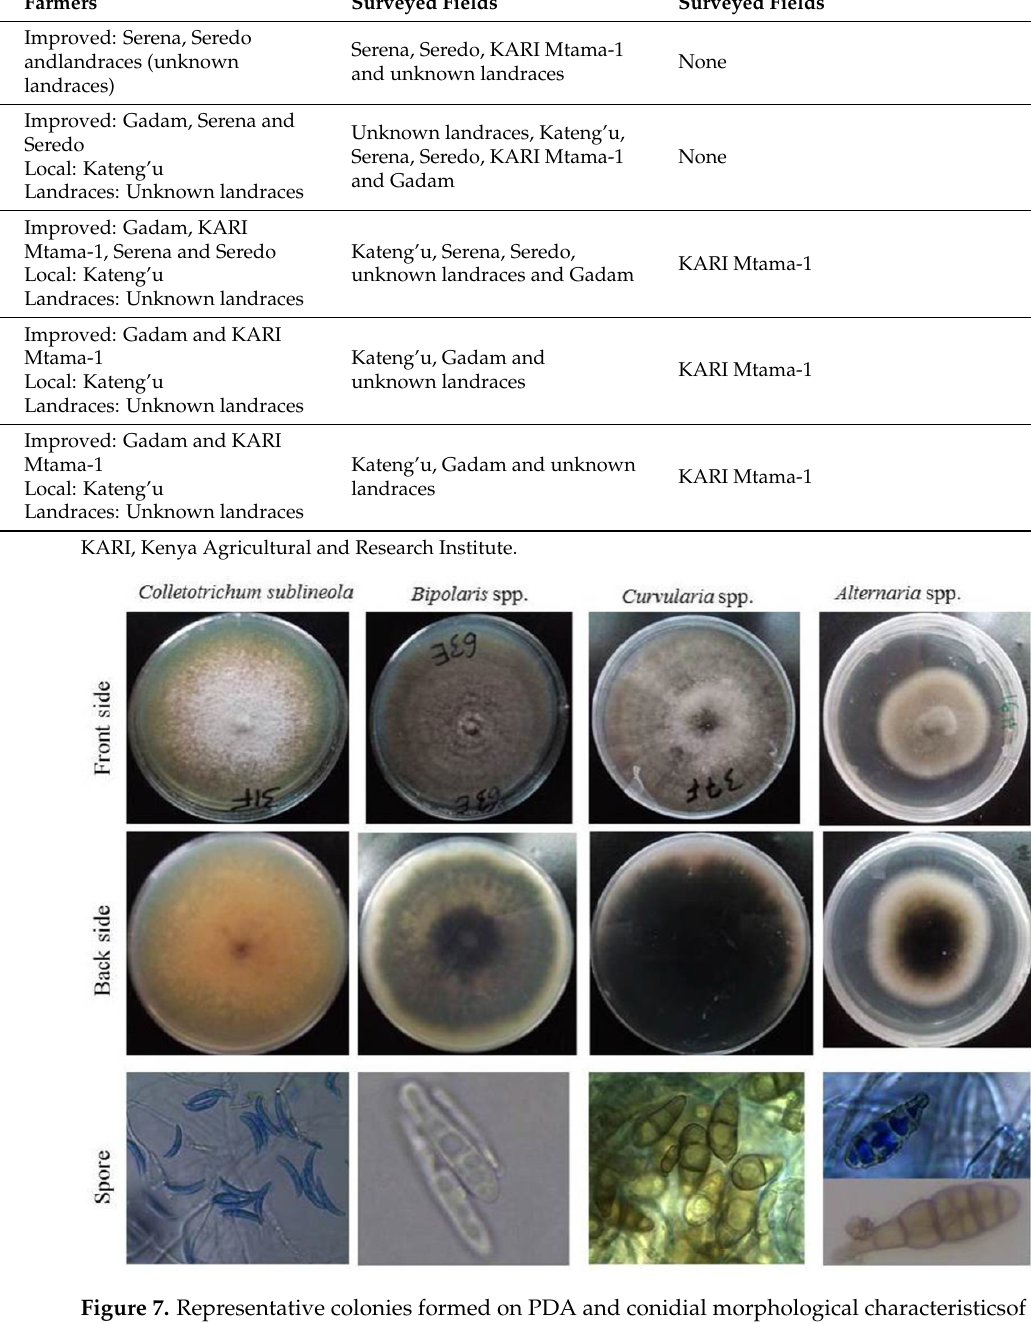
Table 4. Varieties of sorghum identified in the surveyed fields in lower eastern Kenya. Sorghum Varieties Grown by Varieties with Symptoms in the Agro-Ecological Zone Farmers Surveyed Fields